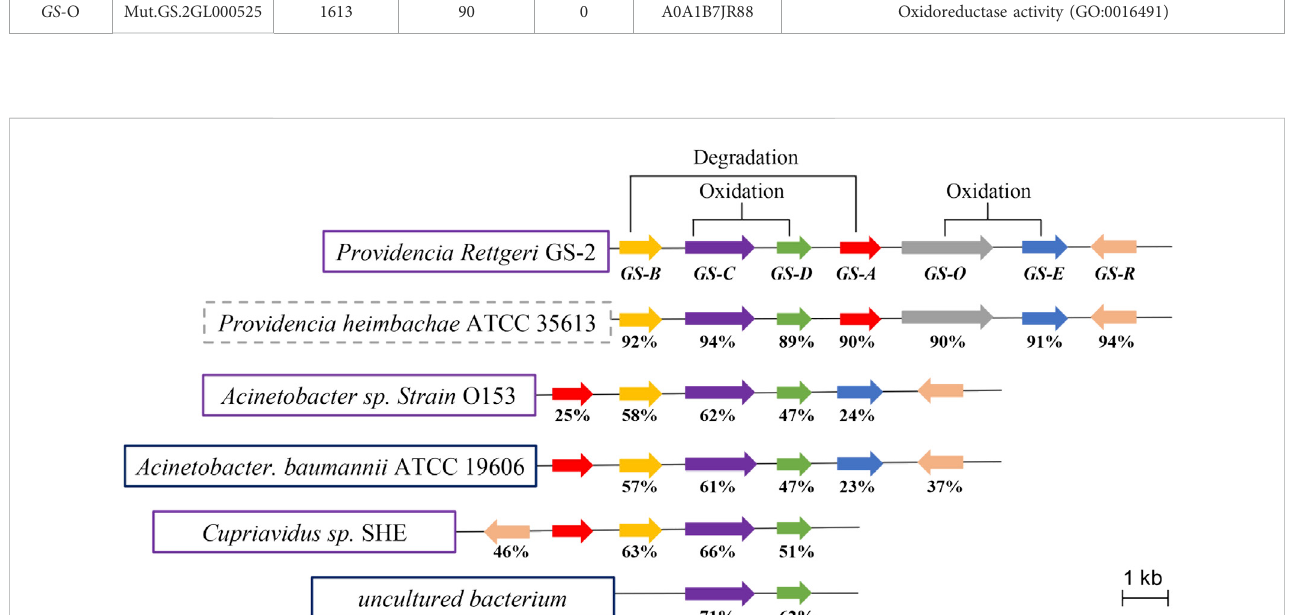
FIGURE 3 Organization and distribution of GS (A-R) genes in different microbial genomes. Genes are represented by arrows (drawn to scale as indicated). Homologous genes are highlighted in the same pattern according to the scheme in the top line for GS-2. Strains and genomic fragments boxed in solid lines indicate reported activity of certain GS-homologous proteins; dashed boxes highlight strains for which indole biodegradation activity was reported at the genelevel.Identities (percent) ofaminoacidsequences betweenGSproteins ofstrainGS-2and homologs